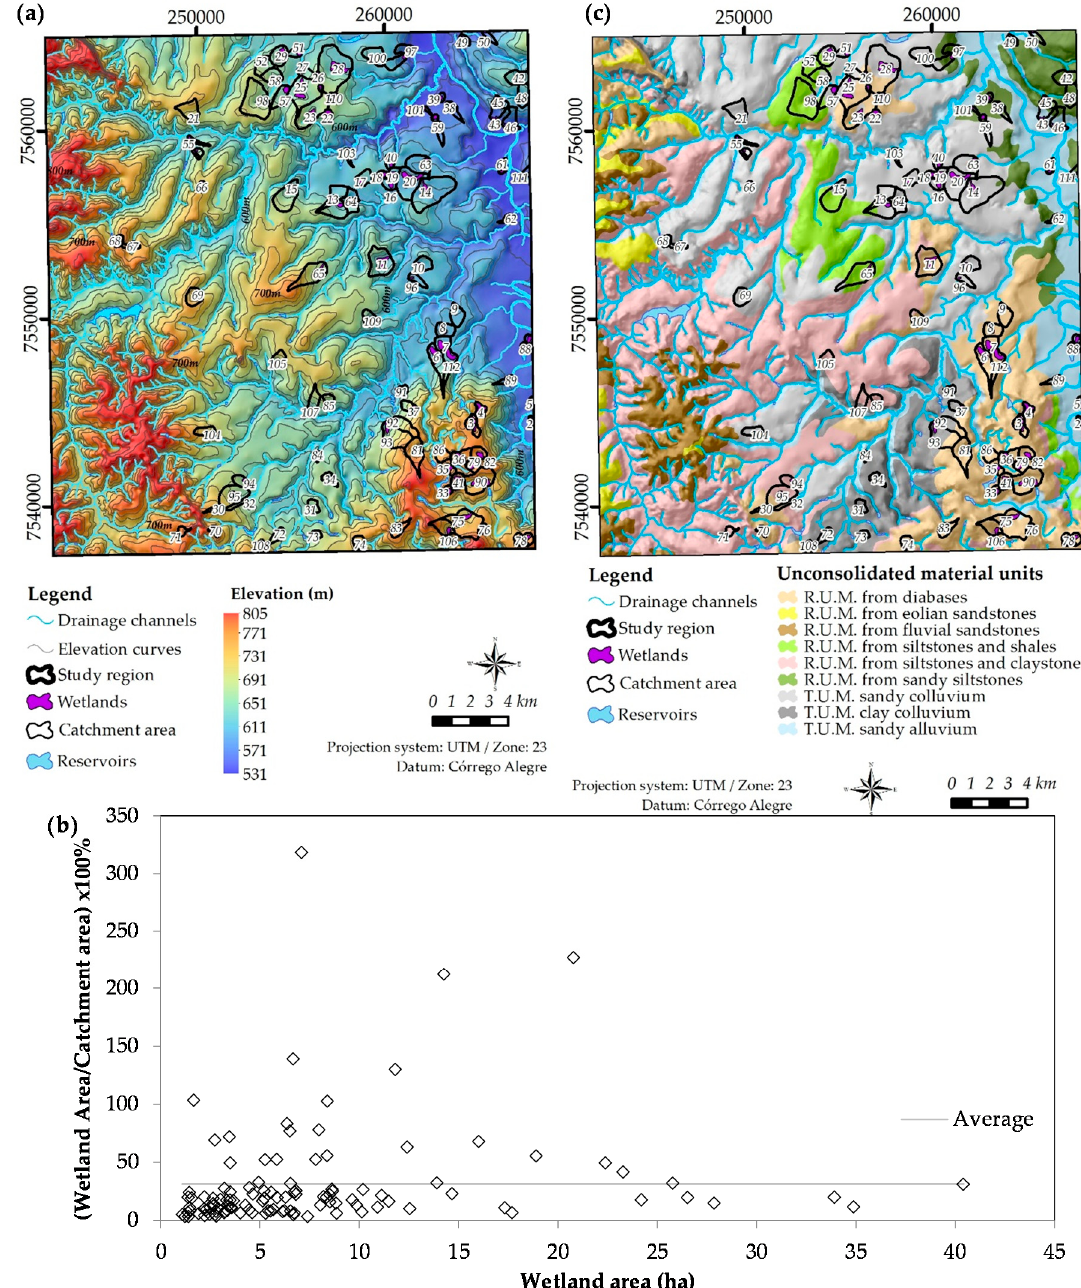
Figure 5. Spatial distribution of wetlands: ( a ) wetland distribution associated with the drainage channel network, elevation curves, digital terrain model, and the corresponding catchment area; ( b ) data regarding the ratio between the extents of a wetland and its catchment area; ( c ) map of unconsolidated materials and wetlands associated with the contribution zones. Legend: R.U.M.: residual unconsolidated material; T.U.M.: transported unconsolidated